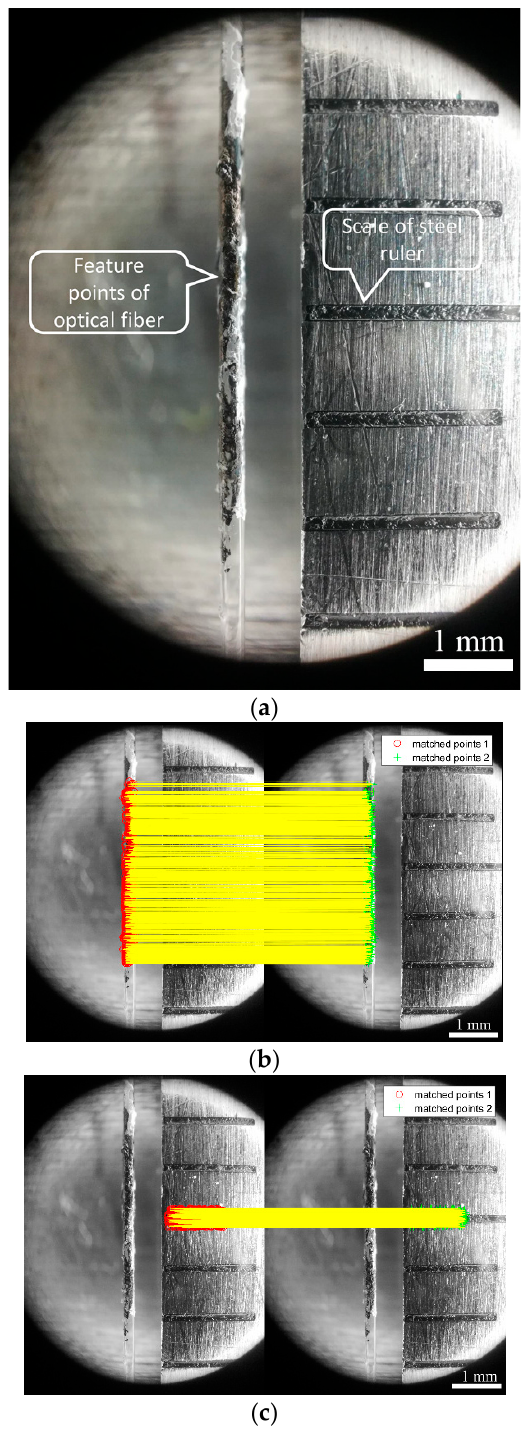
Figure 6. Schematic illustration of the ( a ) Internal layout of micro-scale pictures; ( b ) matched points of the optical fiber; and ( c ) matched points of the steel ruler.